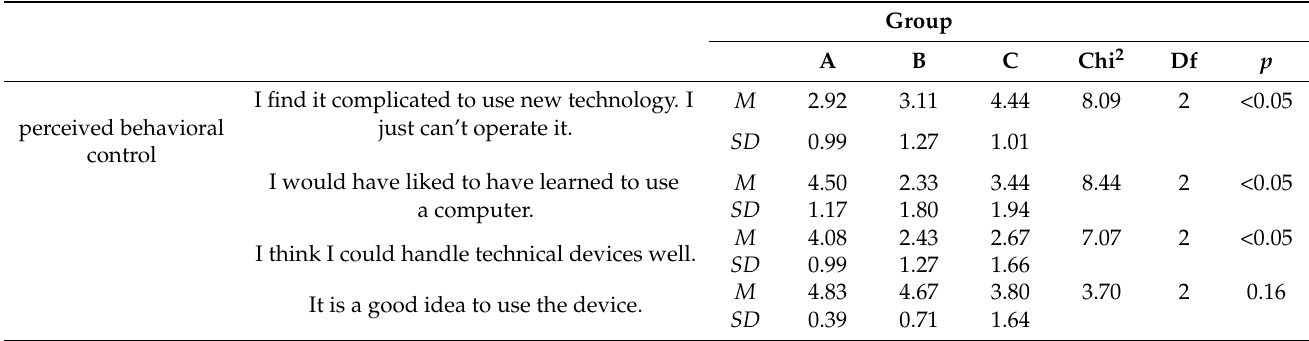
Table 2. Intention to use the device and expected competency with modern technology.